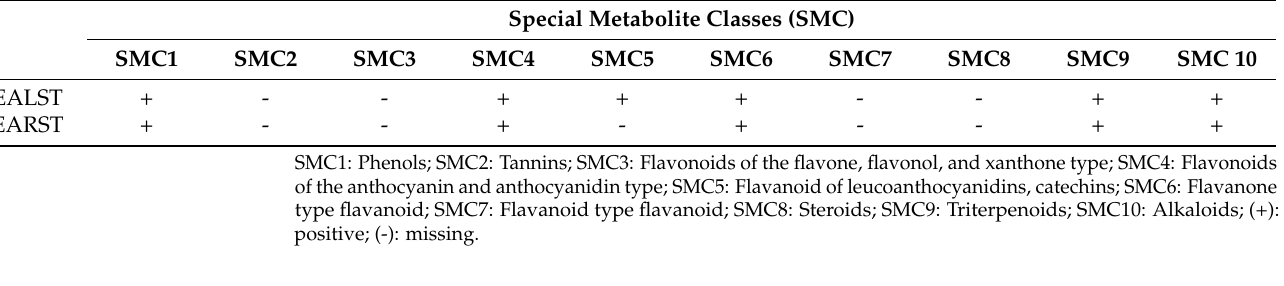
Table 1. Preliminary phytochemical analysis of aqueous extracts of leaves and roots of Spondias tuberosa